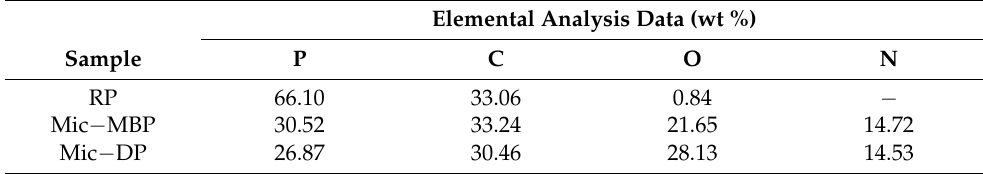
Table 2. The elemental analysis data of RP and Mic − DP.